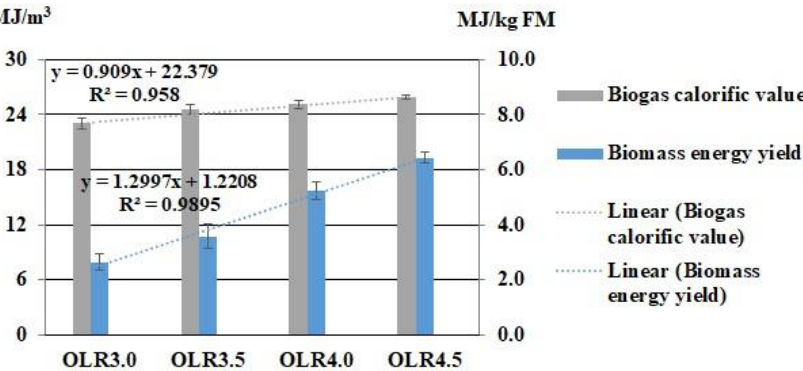
Figure 5. Biogas calorific value and biomass energy yield.